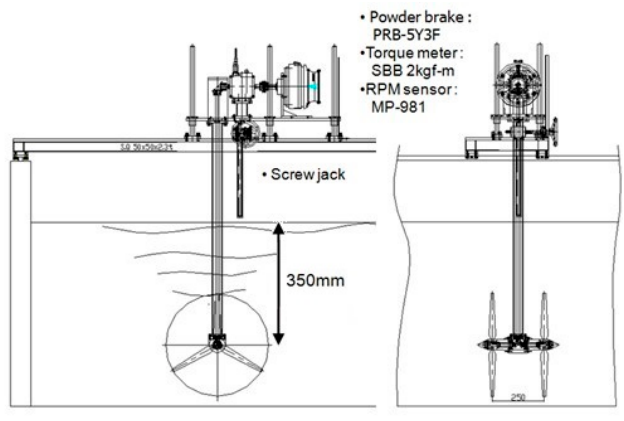
Figure 7. Front and side view of the turbine, measurement equipment, and water tank.